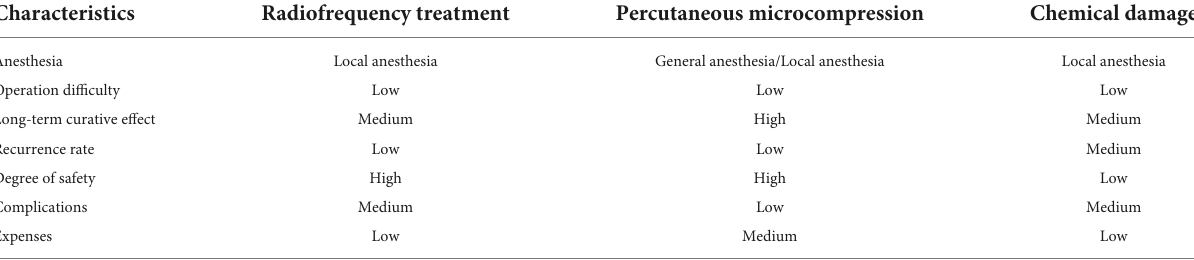
TABLE 2 Comparison of minimally invasive interventional treatments of characteristics for trigeminal neuralgia.